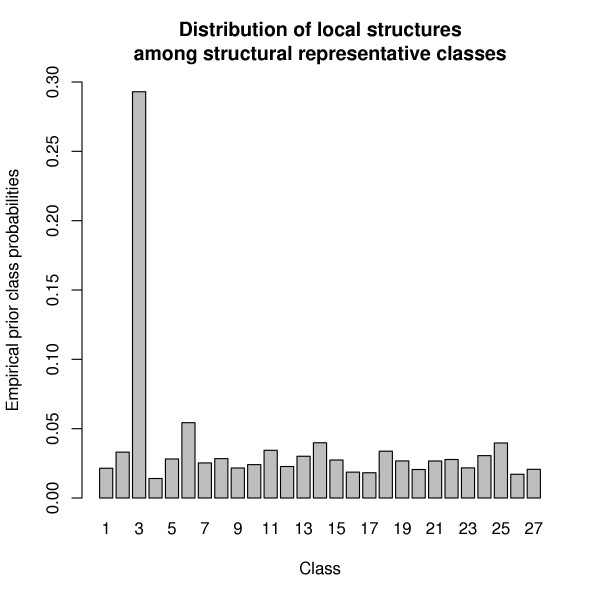
Prior probabilities of the structural classes. The helical fragments (class 3) are clearly dominating the other classes. Extended beta structures are split up into several smaller classes, reflecting their higher structural variability compared to helices.